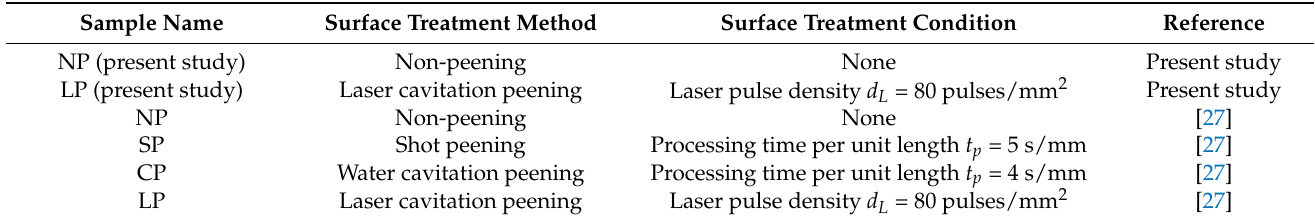
Table 2. Sample names and mechanical surface treatment conditions in Figure